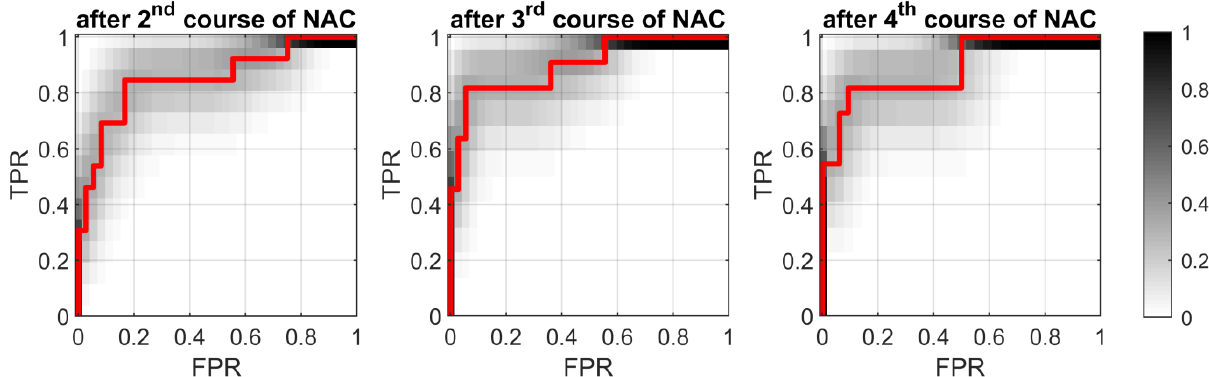
Figure 9. ROC curves (with marked grayscale probability density values) determined for the ∆ KLD parameter after the second, third, and fourth courses of chemotherapy for RMC exceeding 70%.